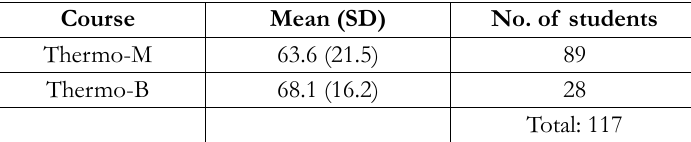
Table 2. The courses’ final test